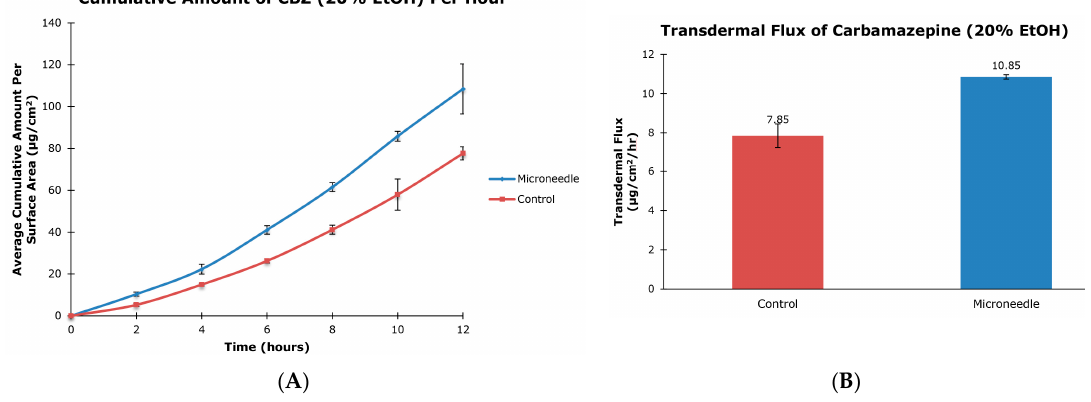
Figure 4. In vitro cumulative amount versus time curve ( A ) and transdermal flux ( B ) of carbamazepine, reconstituted in 20% ethanol, across untreated and microneedle-treated (500 µm needle length) porcine ear skin over 12 h.